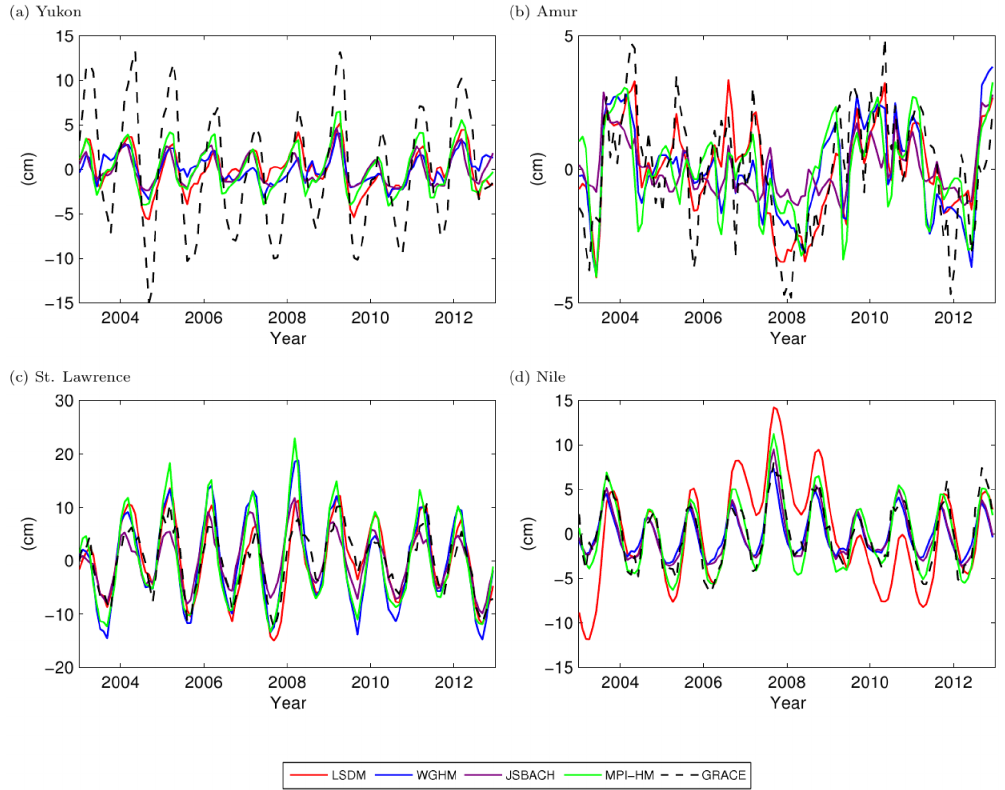
Figure 7. Examples of monthly TWS time series from GRACE and models for the basins with the largest deviation between model and GRACE in each of the four metrics: relative amplitude differences (Yukon), phase differences (Amur), explained variance (St. Lawrence) and explained variance with annual harmonic signal removed